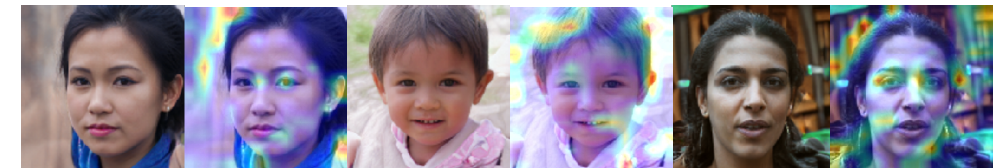
Figure 13. Face images detected as fake. In this figure, the fake face is from the open-source StyleGAN dataset.